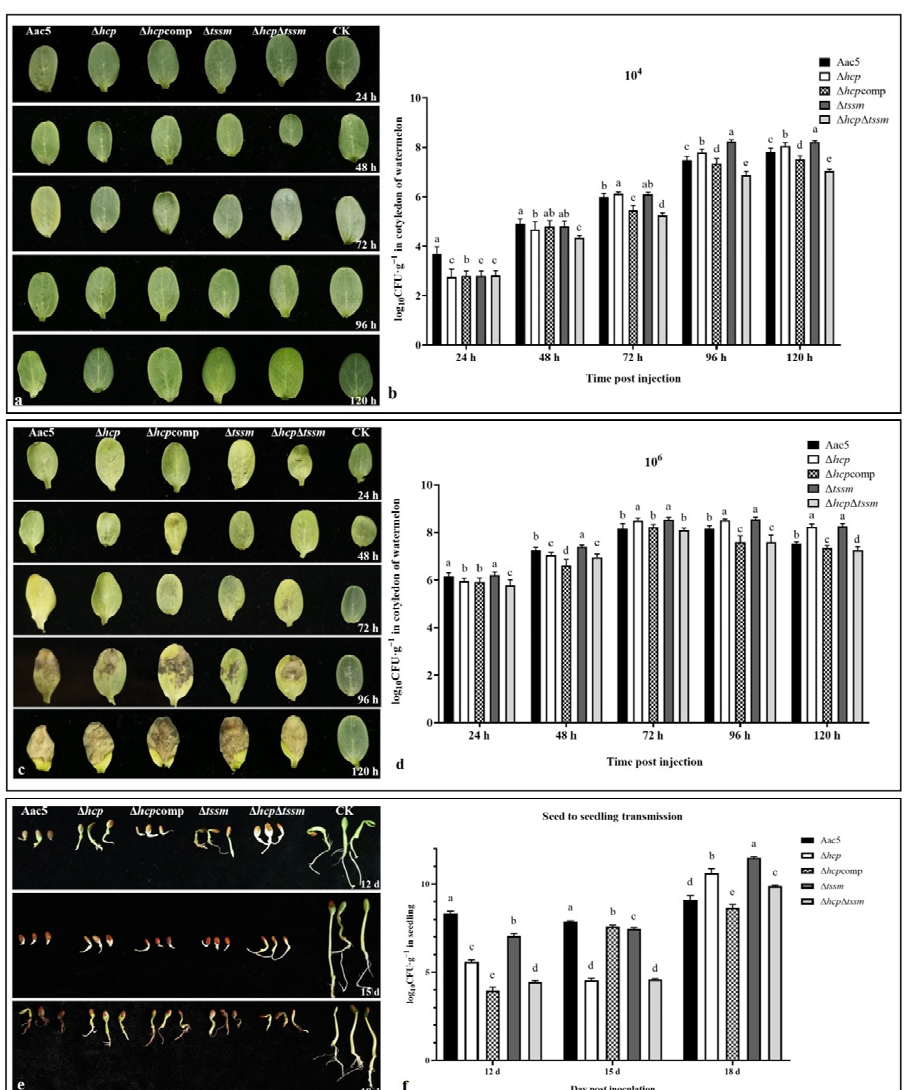
Figure 3. Virulence and colonization of Acidovorax citrulli strains Aac5, ∆ hcp , ∆ hcp comp, ∆ tssm , and ∆ hcp ∆ t ssm . ( a ) Symptoms caused by inoculation with WT, ∆ hcp , ∆ hcp comp, ∆ tssm , ∆ hcp ∆ tssm , and sterile water (CK) at 24, 48, 72, 96, and 120 h post inoculation (hpi). The strains were cultured until the logarithmic phase, washed, resuspended in sterile water at 1 × 10 4 CFU · mL − 1 , and injected into the watermelon cotyledons. ( b ) Bacterial population levels in watermelon cotyledons. Significant differences were found between different letter substitutes on the column calculated by Duncan’s new multiple range test ( p = 0.05). The strains were cultured until the logarithmic phase, resuspended in sterile water at 1 × 10 4 CFU · mL − 1 , and injected into the watermelon cotyledons. ( c ) Symptoms caused by WT, ∆ tssm , ∆ hcp ∆ tssm , ∆ hcp , ∆ hcp comp, and sterile water (CK). The strains were resuspended in sterile water at 1 × 10 6 CFU · mL − 1 and injected into the watermelon cotyledons. ( d ) Bacterial population levels in watermelon cotyledons (1 × 10 6 CFU · mL − 1 ). Significant differences were found between different letter substitutes on the column calculated by Duncan’s new multiple range test ( p = 0.05). ( e ) Disease symptoms on germinating watermelon seeds at 12, 15, and 18 d. The strains were cultured to OD 600 = 0.3 (3 × 10 8 CFU · mL − 1 ), washed, and resuspended in sterile water. Seeds soaked in bacterial suspensions for 4 h were transferred to 15 mL centrifuge tubes containing sterile absorbent cotton, filter paper, and sterile water. ( f ) Bacterial population levels on germinating watermelon seedlings in the seed-to-seedling transmission assay. Significant differences were found between different letter substitutes on the column calculated by Duncan’s new multiple range test ( p =